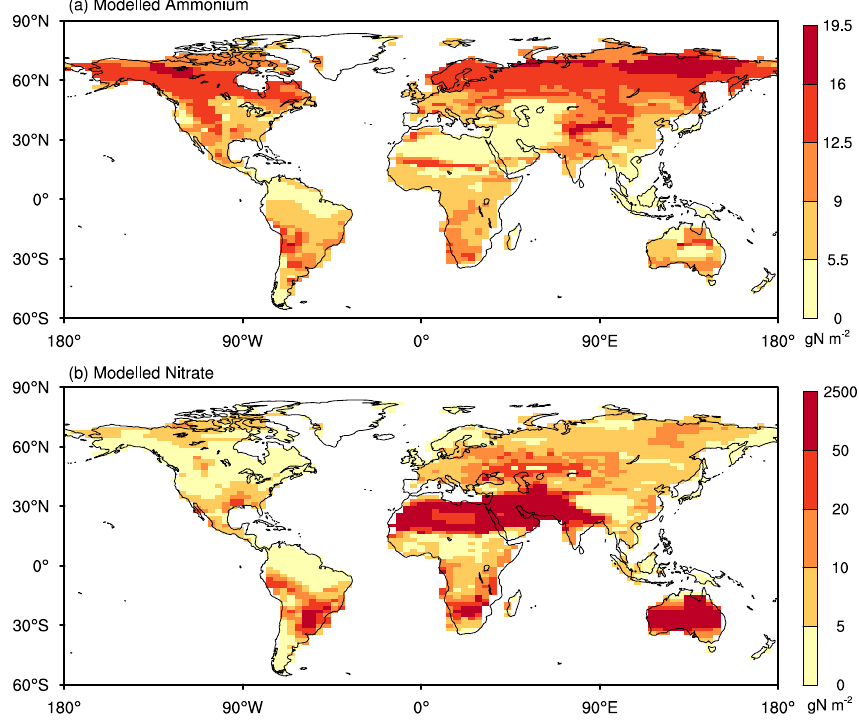
Fig. 4. Mean 1980–1999 ammonium (a) and nitrate (b) pools in the soil simulated by